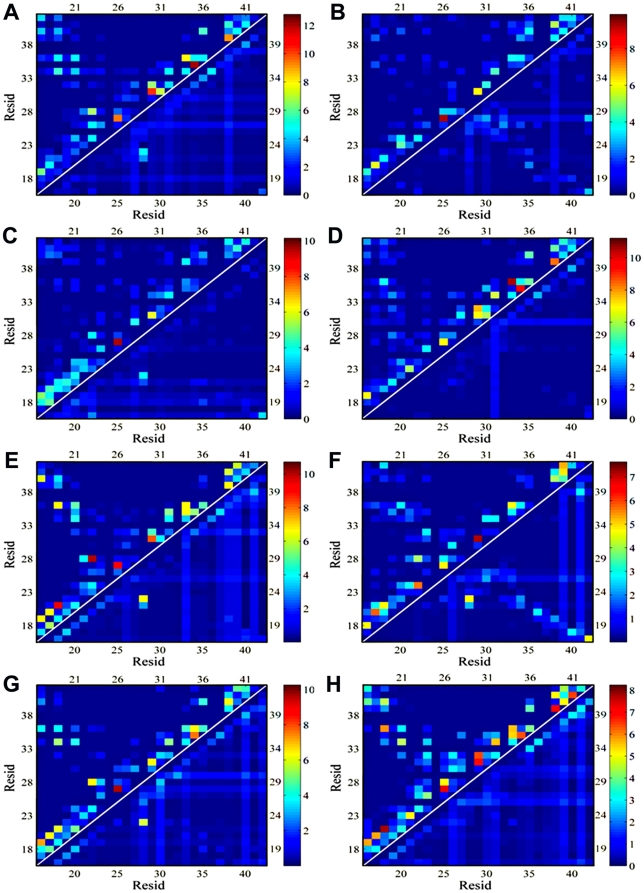
Residue-residue interaction maps including sidechain contacts (upper left triangular corner) and hydrogen bonds (lower right triangular corner) for (A) MWT0, (B) MWT90, (C) MWT170, (D) MMT0, (E) DWT25, (F) DWT265, (G) DWT330, and (H) DMT25.A sidechain contact is defined if the center of mass of sidechains between two residues is less than 6.0 Å. A hydrogen bond is defined if donor-acceptor distance is <3.5 Å and accepter-donor-hydrogen angle is >120°.